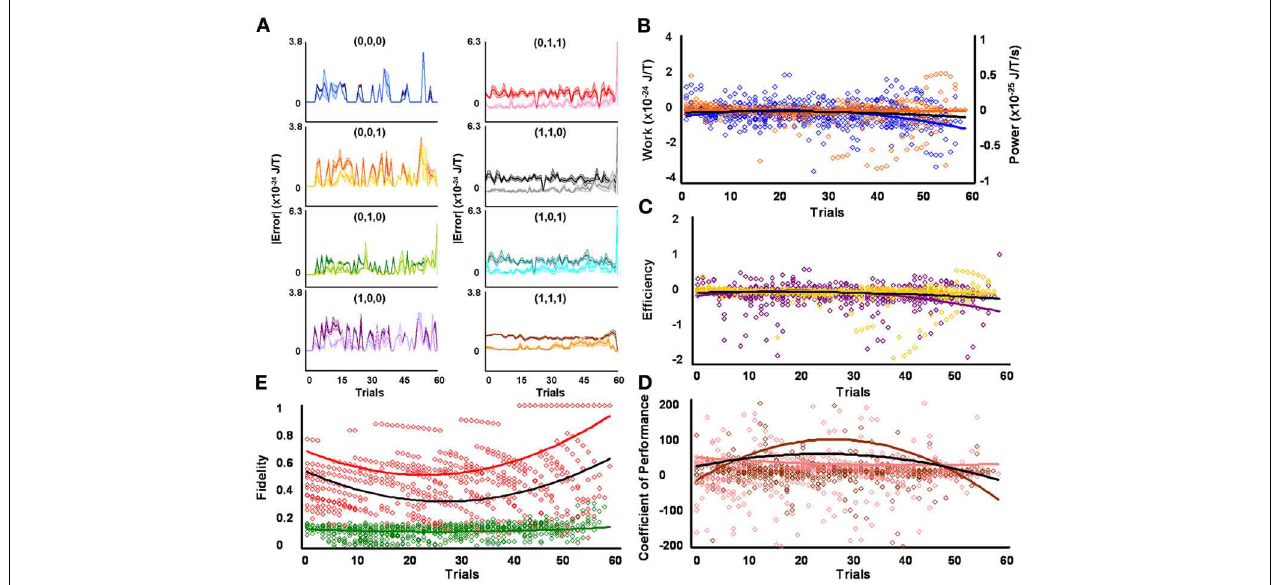
FIGURE 6 | Initial high responders learn to diagnose and correct classical errors in executed reversal strategies signaling mating fitness. (A) Repetition coding prevented errors in executed serial reversal signals from exceeding estimated single bit-flip errors in absolute mean average Boltzmann entropy [executed (light blue) and bit-flipped (dark blue) strategy (0,0,0), executed (light orange) and bit-flipped (dark orange) strategy (0,0,1), executed (lime green) and bit-flipped (green) strategy (0,1,0), executed (lavender) and bit-flipped (purple) strategy (1,0,0), executed (pink) and bit-flipped (red) strategy (0,1,1), executed (gray) and bit-flipped (black) strategy (1,1,0), executed (turquoise) and bit-flipped (teal) strategy (1,0,1), executed (gold) and bit-flipped (brown) strategy (1,1,1)]. (B) Differences in mean average Boltzmann entropy between strategy planning and execution stages were expelled by ciliates when learning to detect and correct errors in modal (orange) and non-modal (blue) serial reversal signals. Negative trends in work and associated power functions show that serial strategies